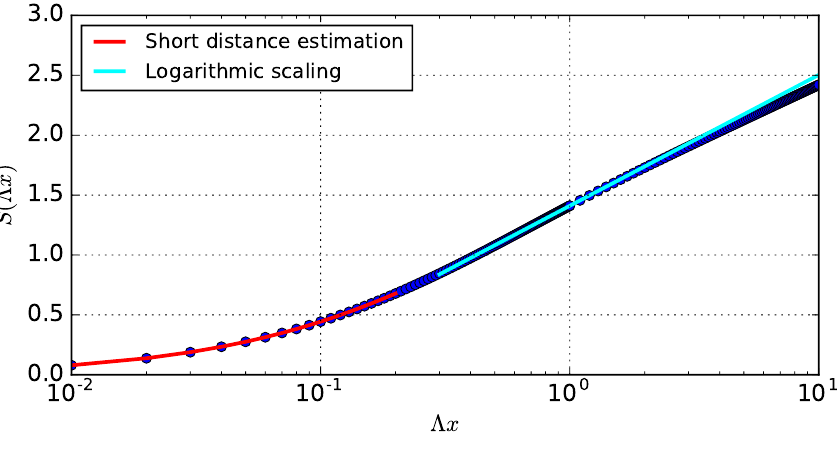
Figure 7 . Numerical computation of the entanglement entropy pro(cid:12)le ((cid:3) a = 0 : 01, " = 10 (cid:0) 6 ) for a 1+1 dimensional Klein-Gordon theory. The short range theoretical estimation and the long distance logarithmic scaling have been